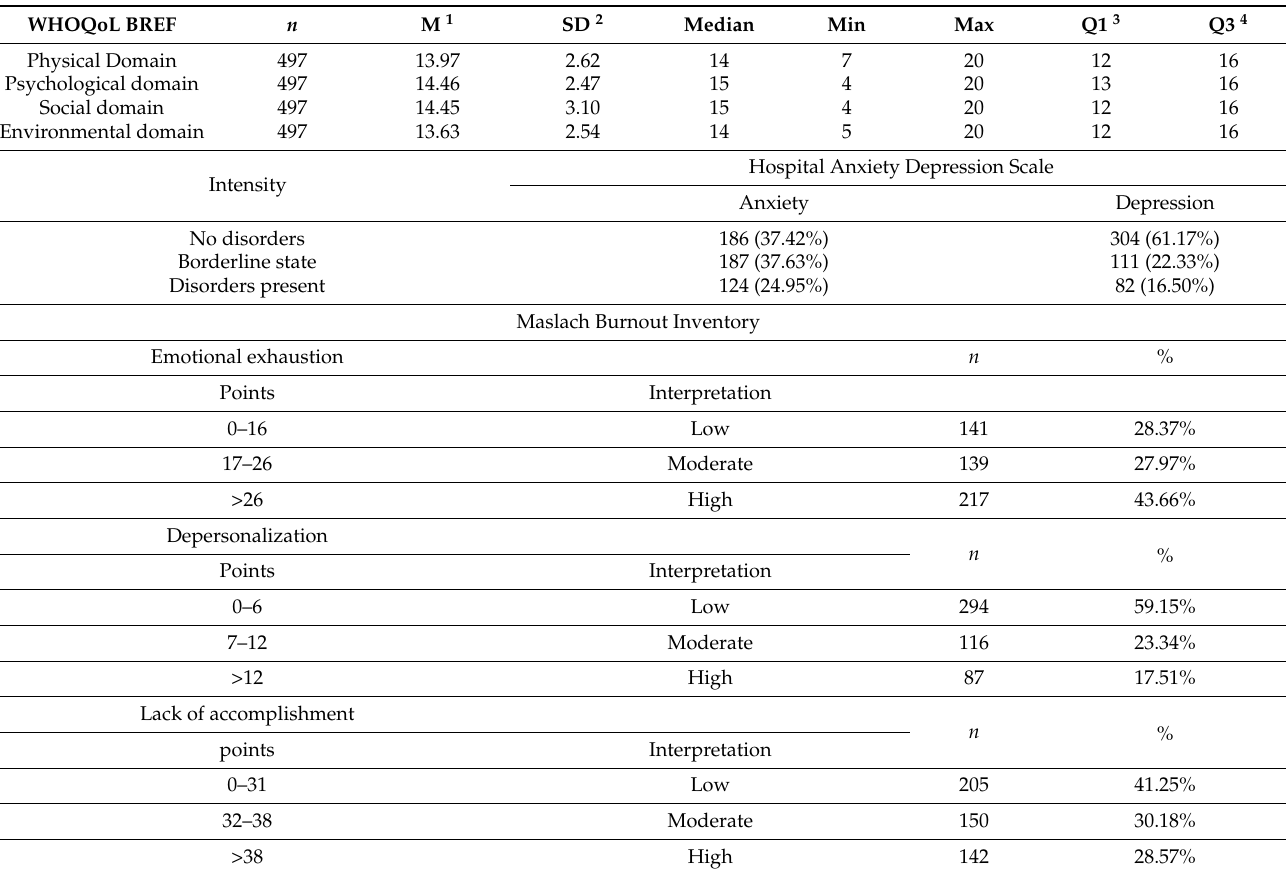
Table 2. Occupational burnout quality of life and level of anxiety and depression in healthcare workers during the